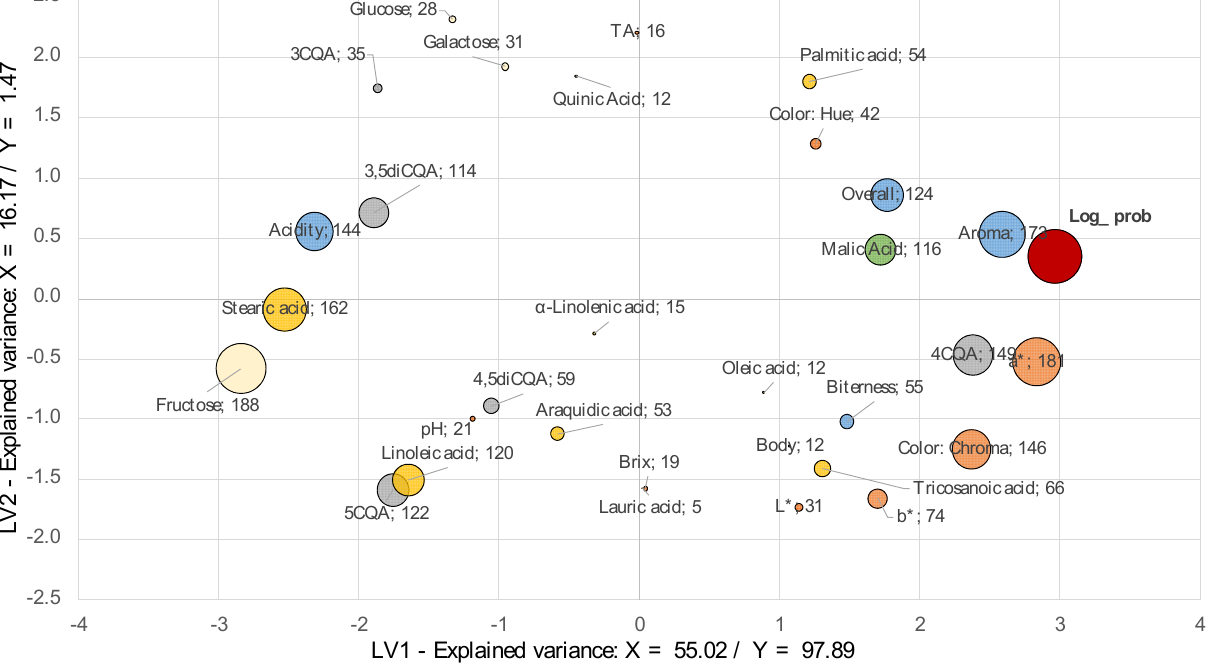
Figure 4. Loadings plot for BIB concentrate samples, storage during 12 months at 25 ◦ C by boo -strapped—feature selection version of PLS analysis. Color depicts feature type: red—log-acceptability ratio, blue—sensory, gray—CQAs, yellow: organic acids and orange—physicochemical; bubble size represents variable relevance.